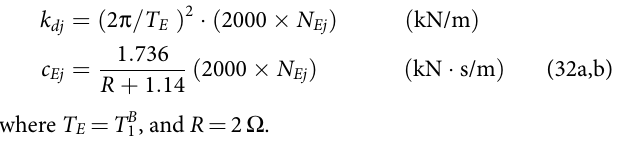
parameter in terms for the minimization of the installed T-EIMDs with a limited